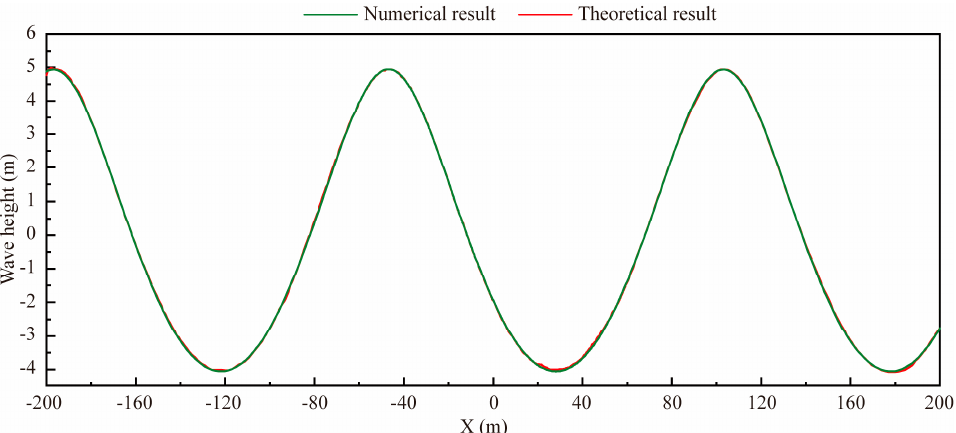
Figure 10. Distribution of wave height position points along the propagation direction.